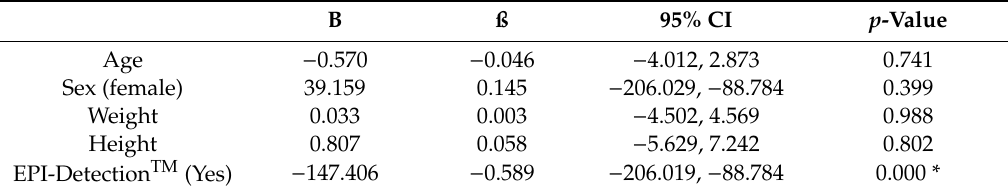
Table 3. Factors predictive of total operation time with regard to cervical epidural steroid injection. B ß 95% CI p -Value Age −